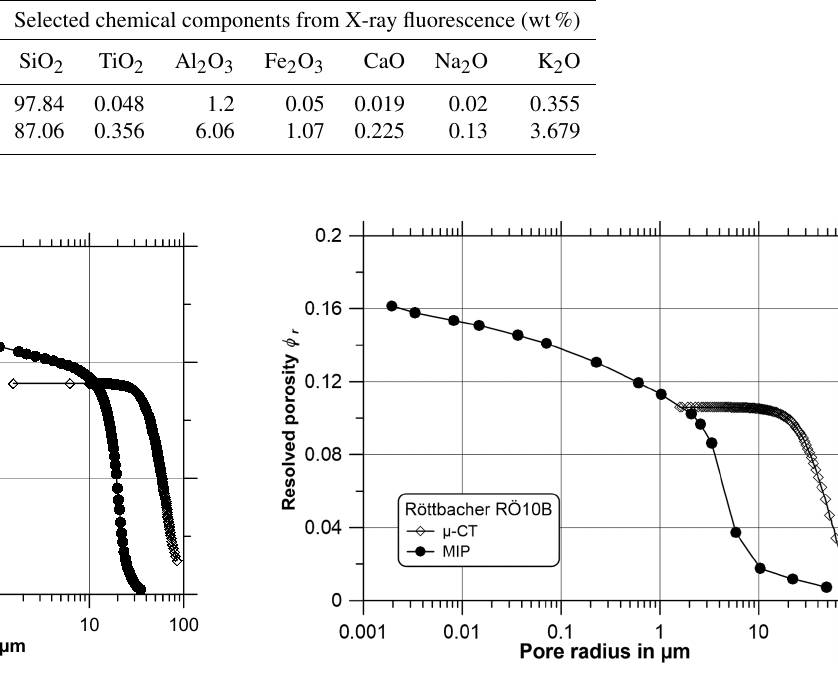
Table 2. Chemical components of the samples from X-ray fluorescence analysis.